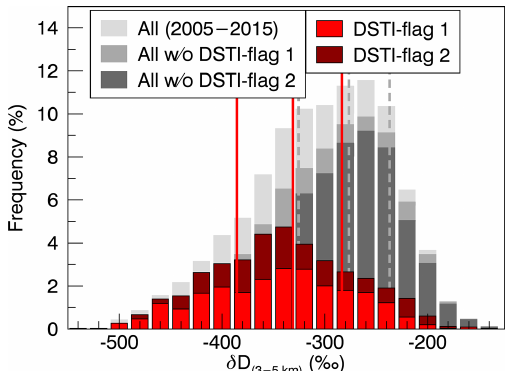
Figure 11. Distribution of lower-tropospheric δ D (deseasonal- ized hourly means) for deep-stratospheric-intrusion events identi- fied from Zugspitze in situ observations using two different flags (DSTI-flag 1: RH<60% and Be-7>85th percentile; DSTI-flag 2: RH<60% and 1 × RH<30% within ± 6h). For comparison the distribution is shown for all FTIR measurements coincident with in situ data in 2005–2015 as well as all data excluding DSTI events. Vertical lines indicate median and 25th–75th-percentile range of the distribution for DSTI-flag 1 and all data without DSTI-flag